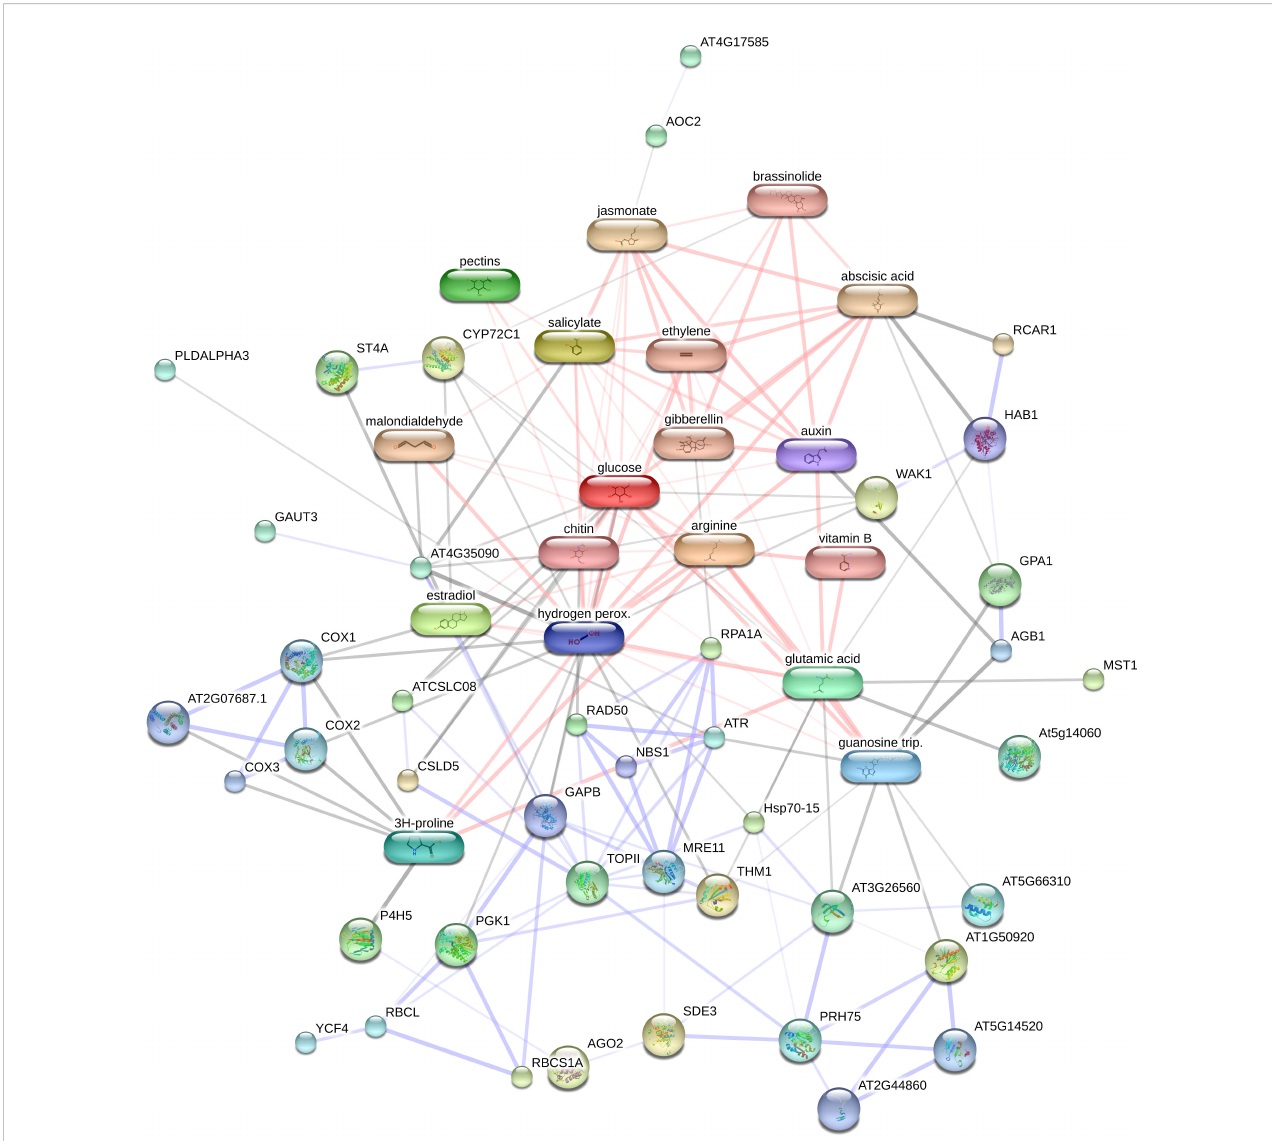
FIGURE 4 Analysis of the network of protein – chemical of identi fi ed proteins using STITCH 5.0. AT2G44860, large subunit ribosomal protein L24e; AT3G17530, F- box and associated interaction domain-containing protein; WAK1, Serine/threonine-protein kinase; At5g14060, aspartokinase 2; SDE3, SILENCINGDEFECTIVE; AT1G11780, alpha-ketoglutarate-dependent dioxygenase alkB; ST4A, sulfotransferase 4A; AGO2, argonaute 2;P4H5, prolyl 4- hydroxylase 5; AOC2, allene oxide cyclase 2; THM1, thioredoxin M1, RPA1A, replication factor A1; YCF4, unfolded protein binding; GPA1, G protein alpha subunit 1; NBS1, nijmegen breakage syndrome 1; PLDALPHA3, phospholipase D; RBCS1A, ribulose bisphosphate carboxylase small chain 1A, AT4G35090, catalase 2; TOPII, topoisomerase II; AT4G17585, aluminum activated malate transporter family protein;HAB1, HYPERSENSITIVE TO ABA1; CSLD5, 1,4-beta-D-xylan synthase; AT5G14520, pescadillo-related protein; MST1, thiosulfate sulfurtransferase;COX1, cytochrome oxidase; AT3G26560, ATP-dependent RNA helicase DHX8/PRP22; RCAR1, abscisic acid receptor PYL9; RAD50, DNA repair protein RAD50; RBCL, ribulose-bisphosphate carboxylases;ATCSLC08, putative xyloglucan glycosyltransferase 8; GAUT3, galacturonosyltransferase 3; PGK1, phosphoglycerate kinase 1;PRH75, DEAD-box ATP-dependent RNA helicase 7; AT5G66310, ATP binding microtubule motor family protein; ATR, serine/threonine-protein kinase ATR;AGB1, GTP binding protein beta 1; CYP72C1, cytochrome p450 72c1; AT2G07687.1, cytochrome c oxidase subunit 3; COX3, cytochrome c oxidase subunit 3; MRE11, MEIOTIC RECOMBINATION 11; COX2, cytochrome oxidase 2; Hsp70-15, Heat shock protein